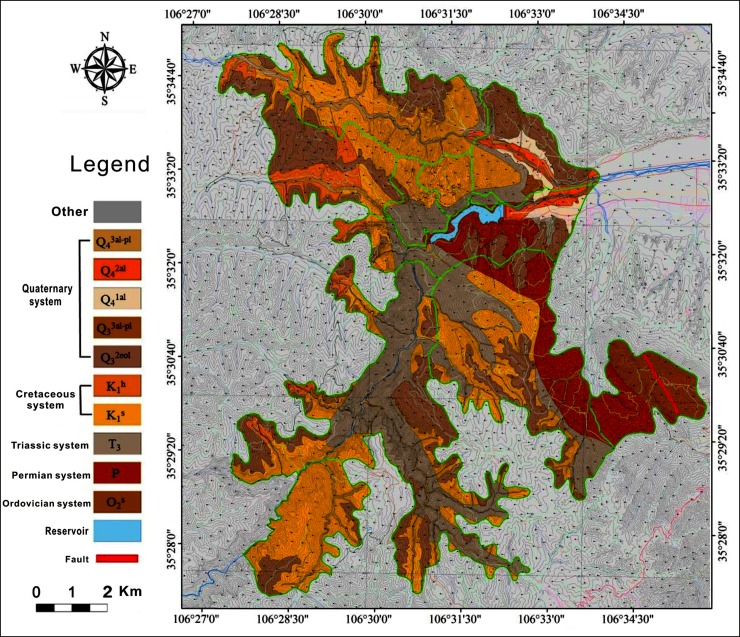
Geological map of the KNG.Fig 3 is excluded from this article's CC-BY license. See the accompanying retraction notice for more information.